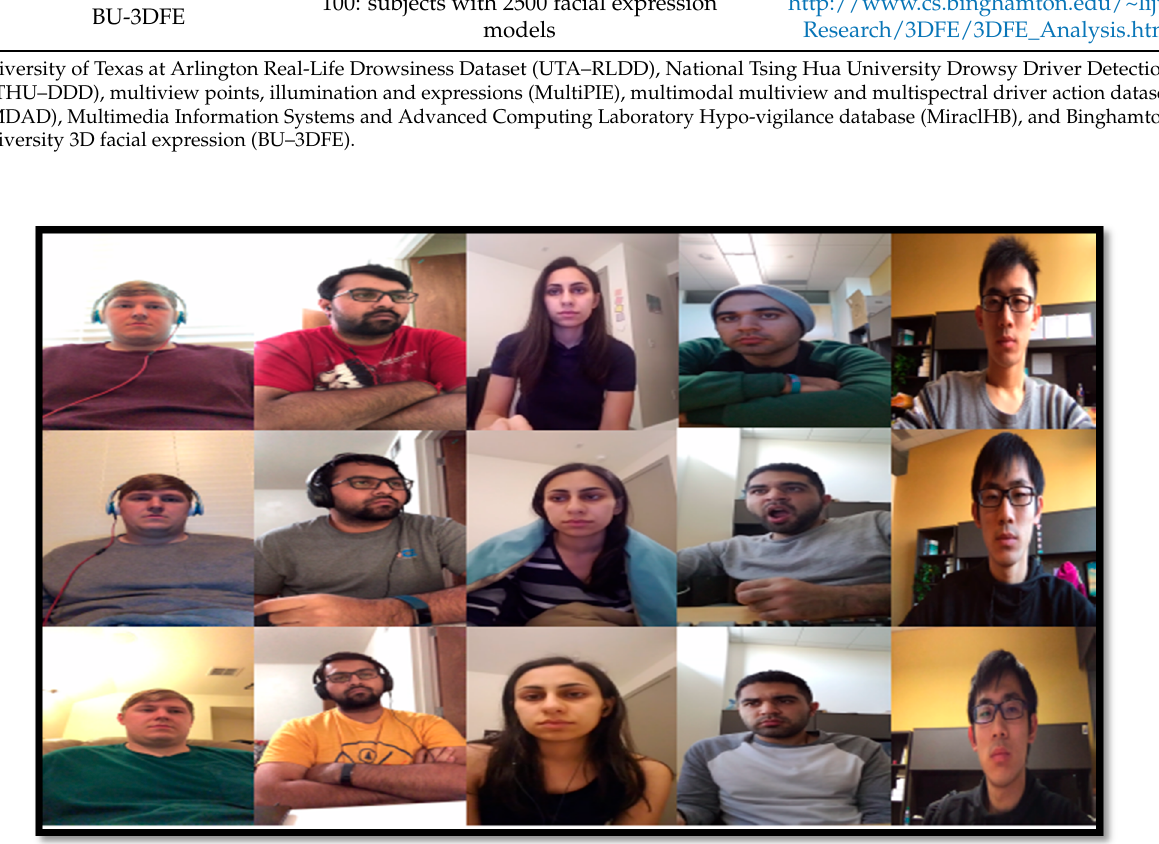
Figure 4. An example of sample frames that are taken from the University of Texas at Arlington Real-Life drowsiness dataset (UTA–RLDD) [180] in the alert (first row), low vigilant (second row), and drowsy (third row) states.